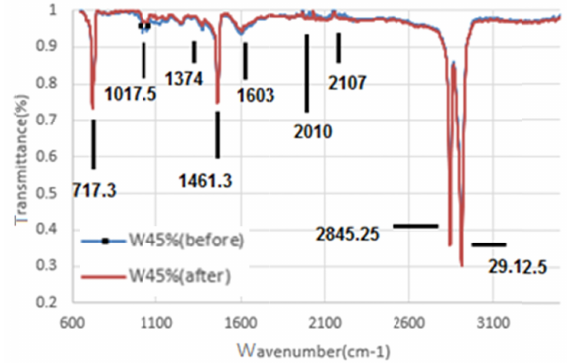
Fig. 9. ATR s gamma